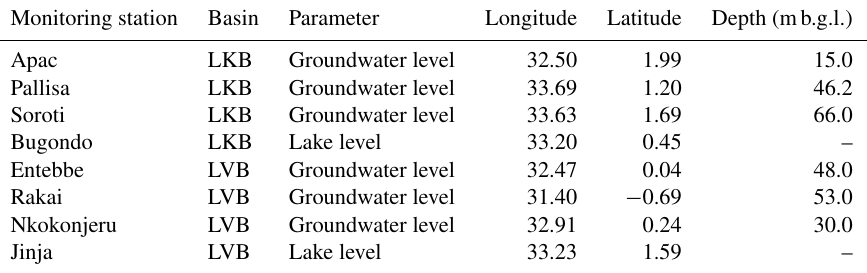
Monitoring station Basin Parameter Longitude Latitude Depth